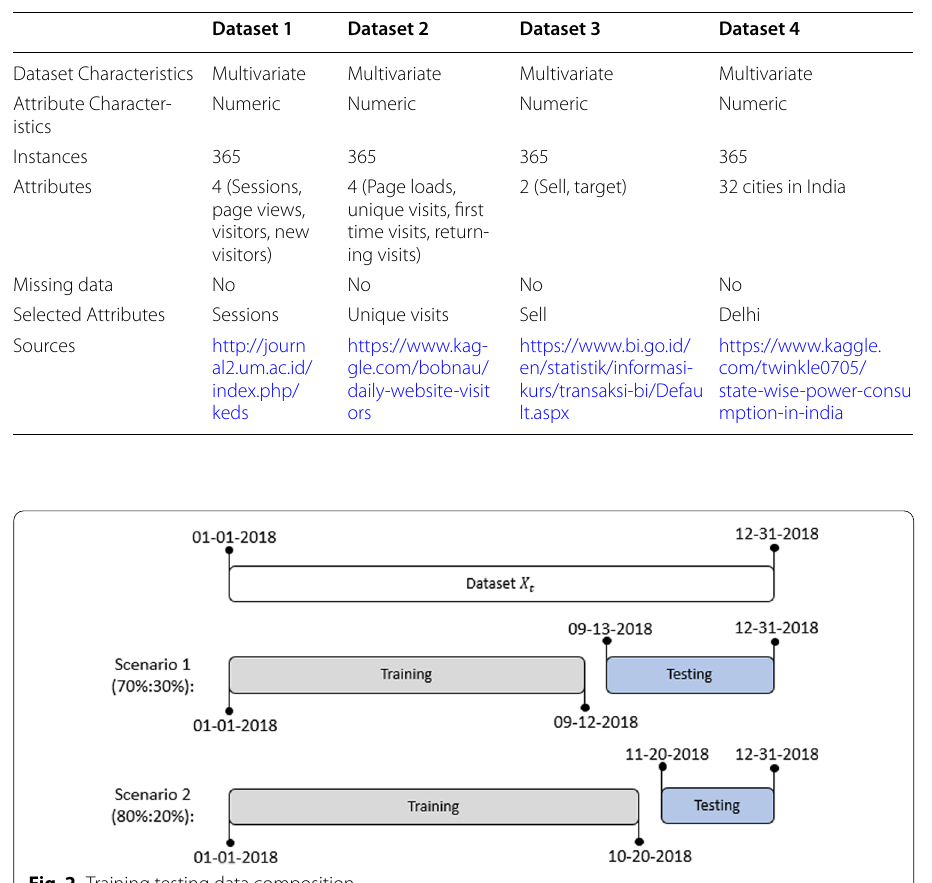
Table 3 Dataset Description